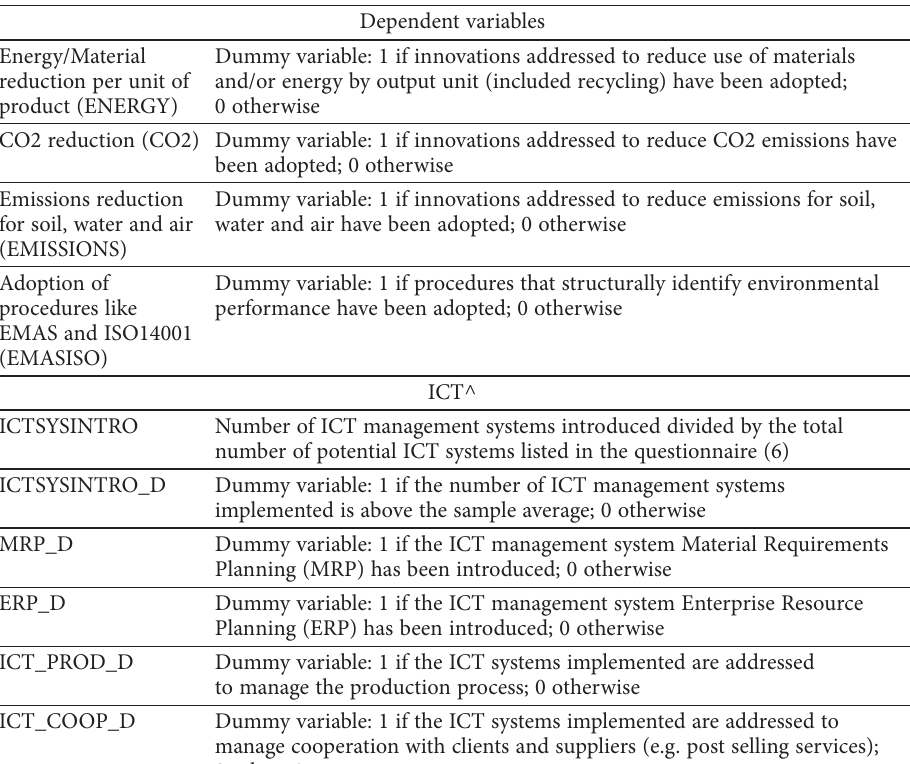
Dependent variables